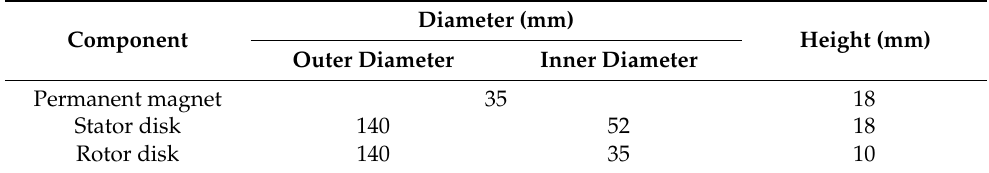
Table 3. Dimensions of electromagnetic damper components.